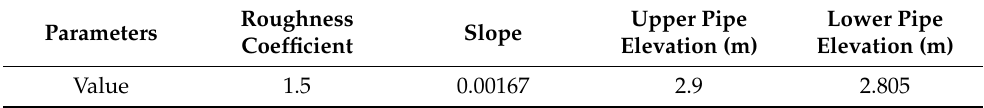
Table 4. Other important parameters in design of the intercepting